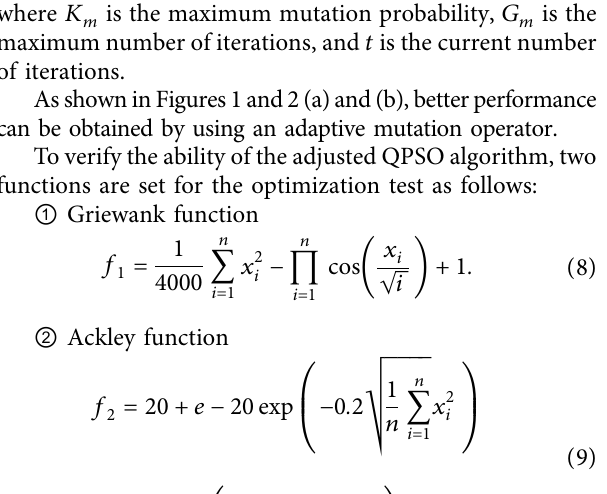
Figure 2: Flow chart of the QPSO-CLS joint